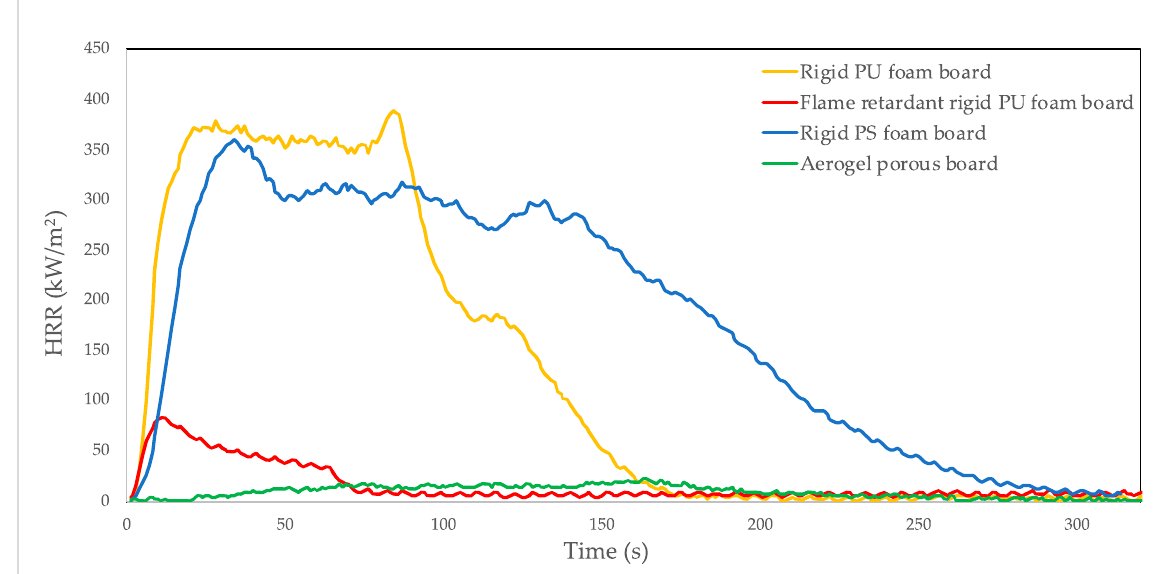
Figure 7. HRR curves of different EWIs under the 50 kW/m 2 radiant heat flux.